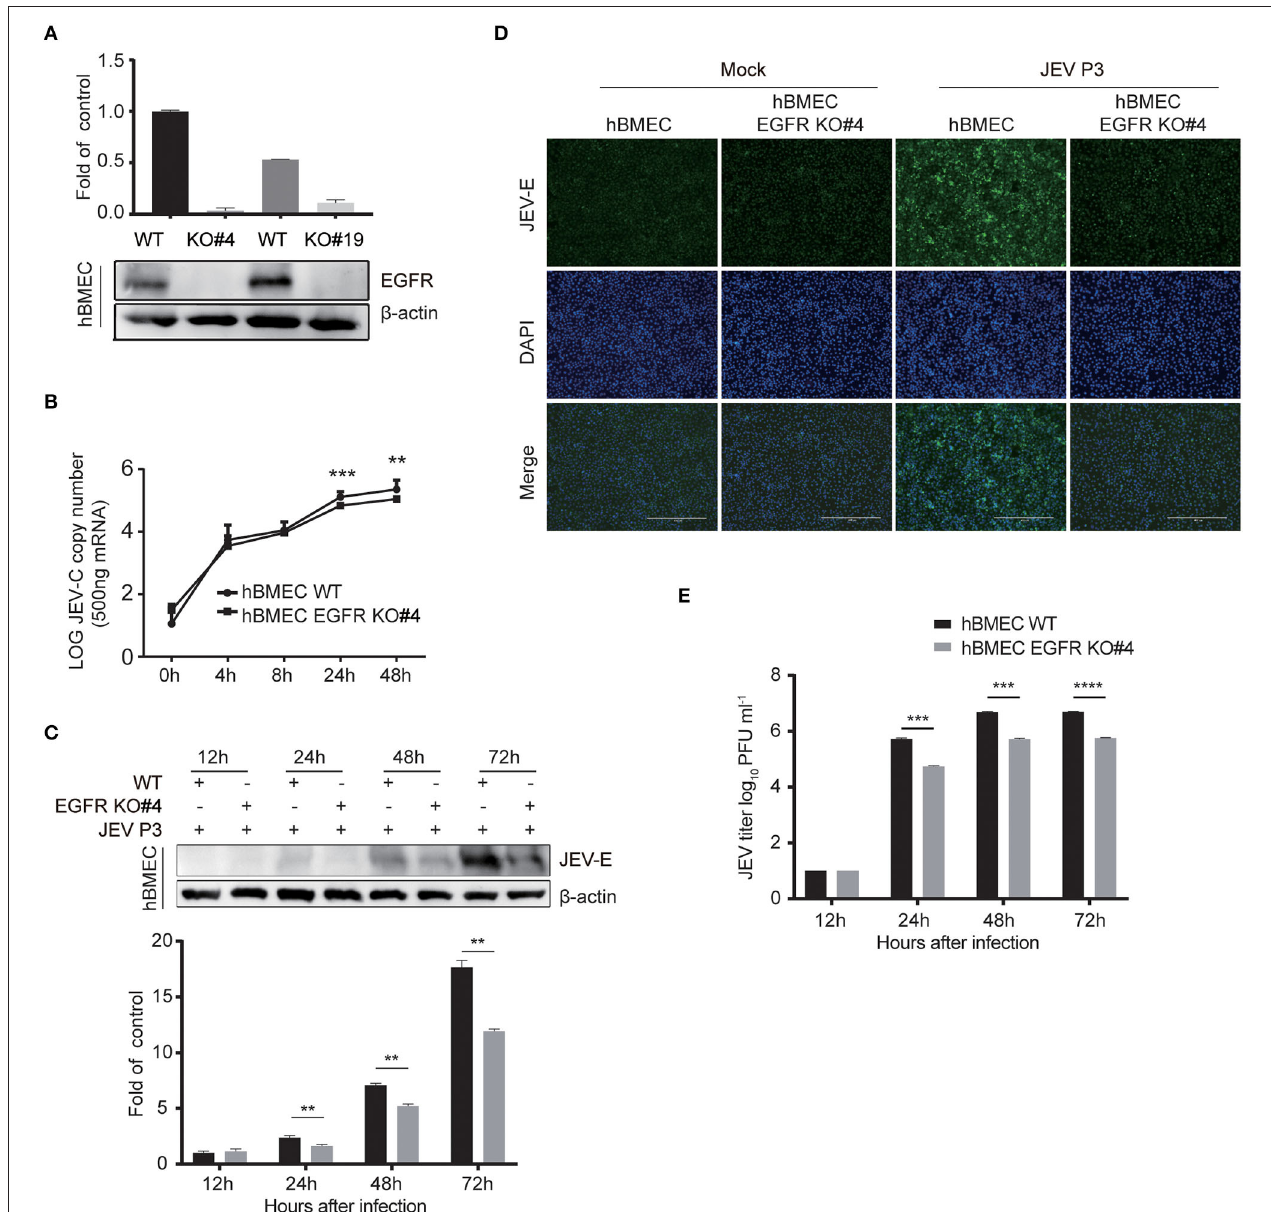
FIGURE 4 | Viral infection was reduced in EGFR knockout hBMECs. (A) The verification of the EGFR knockout was measured with Western blotting in hBMECs. Results were quantified. (B) The comparison of JEV P3 replication between wild-type and EGFR-KO hBMECs over time by quantitative real-time PCR. (C) Western blotting assay was performed to determine the expression of JEV-E protein at different times in wild-type and EGFR-KO hBMECs. Results were quantified. (D) Wild-type and EGFR-KO hBMECs were infected with JEV P3 for 24h, and then immunofluorescence (IF) staining was performed to detect JEV-E protein with JEV-E protein monoclonal antibody. Nuclei were stained with DAPI. Scale bar, 400 µ m. (E) Supernatants in JEV P3-infected wild-type and EGFR-KO hBMECs were collected over time, and the viral titer was detected in BHK-21 cells by plaque assay. The results are represented as mean ± SEM values from three independent experiments. **, p < 0.01; ***, p < 0.001; ****, p <